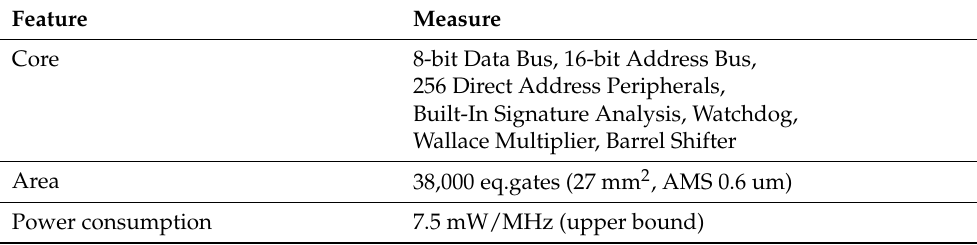
Figure 7. The degrading effect of the activity reduction on the input of a two-rail checker. Table 2. The main characteristics of the CoSafe processing core.